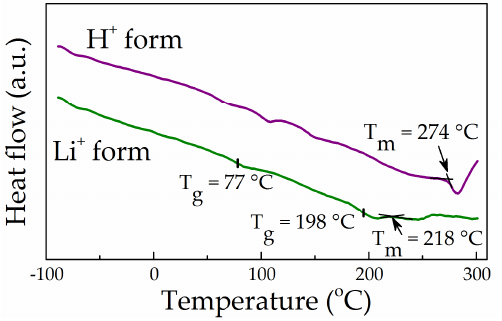
Figure 6. Differential scanning calorimetry (DSC) curves for the “dry” samples of Nafion 115 in H + and Li + forms.